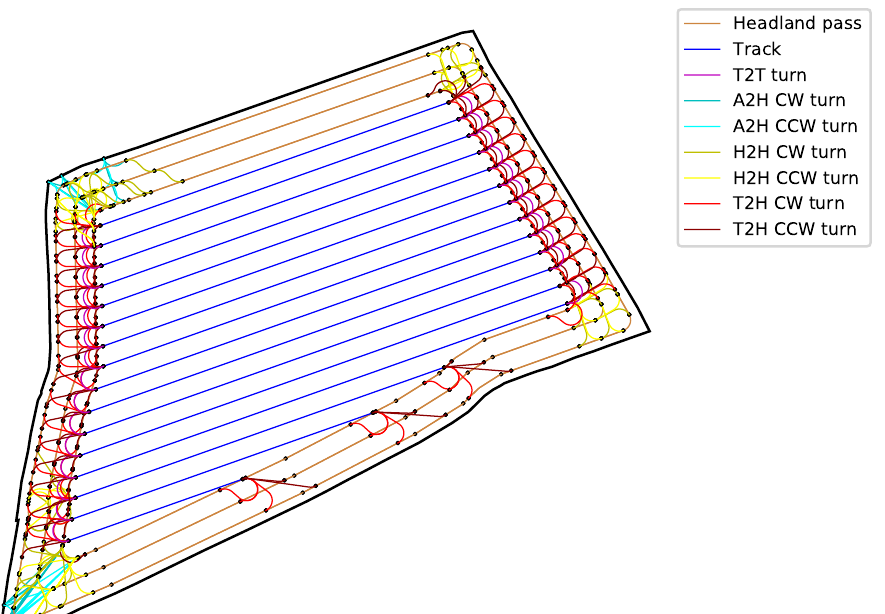
Figure 3. Field partitioning of field No. 4 (Table 1) showing the complete grid of graph vertices (black dots) and arcs, i.e., the path network that all PUs and SUs are allowed to traverse, while the headland passes (’Headland pass’) and tracks (’Tracks’) which in combination constitutes the area that must be covered by the PU. The following abbreviations in combination explains the illustration of the generated output of all possible turning paths, connecting passes, and field access passes. T: main field track; H: headland; 2: maneuvering between; A: field access; CW: clockwise manoeuvre; CCW: counter clockwise manoeuvre.